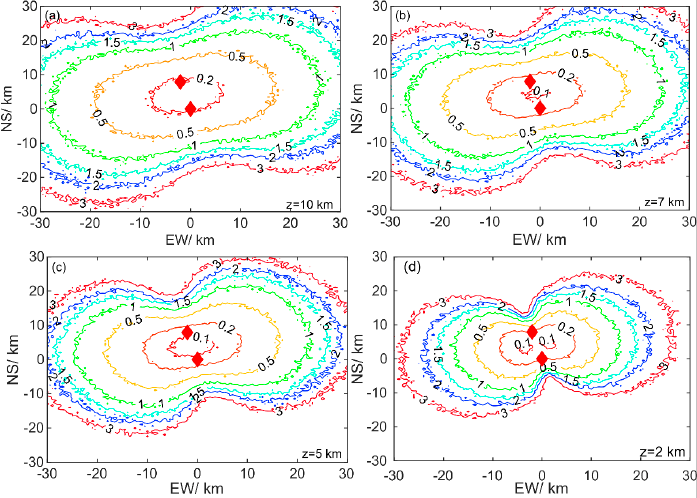
Figure 3. The locating error distribution map at different heights. ( a ) 10 km height; ( b ) 7 km height; ( c ) 5 km height; ( d ) 2 km height. The unit of locating error is